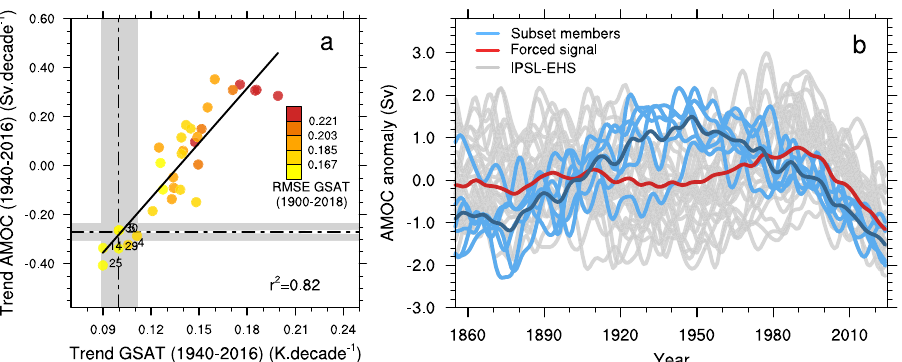
Fig. 2 Relationship between GSAT and AMOC over the historical period. a Scatter plot of Global near-Surface Air Temperature (GSAT) (K decade − 1 ) versus Atlantic Meridional Overturning Circulation (AMOC) (Sv decade − 1 ) trends calculated over the 1940-2016 period from the IPSL ensemble of extended historical simulations (IPSL-EHS; fi lled circles) and the observations (dot-dashed lines), with HadCRUT4-CW 41,42 for the temperature and the Caesar index 17 as a proxy for the AMOC evolution, with the related uncertainties (gray). The black solid line represents the least square regression between these two variables in IPSL-EHS, with a determination coef fi cient r ² = 0.82 ( p < 0.1, see Method). The color scale represents the RMSE between simulated and observed (HadCRUT4-CW 41,42 ) annual GSAT anomalies over the period 1900 – 2018. b Time evolution of the low-pass fi ltered AMOC strength anomaly from IPSL-EHS (gray), the AMOC forced signal (or ensemble mean, red), and the subset of 6 members labelled in a (light blue), with the subset average (dark blue). The anomaly is calculated for each member with respect to its 1850 – 2018 average. A Lanczos low-pass fi lter with a cutoff period of 11 years is used.